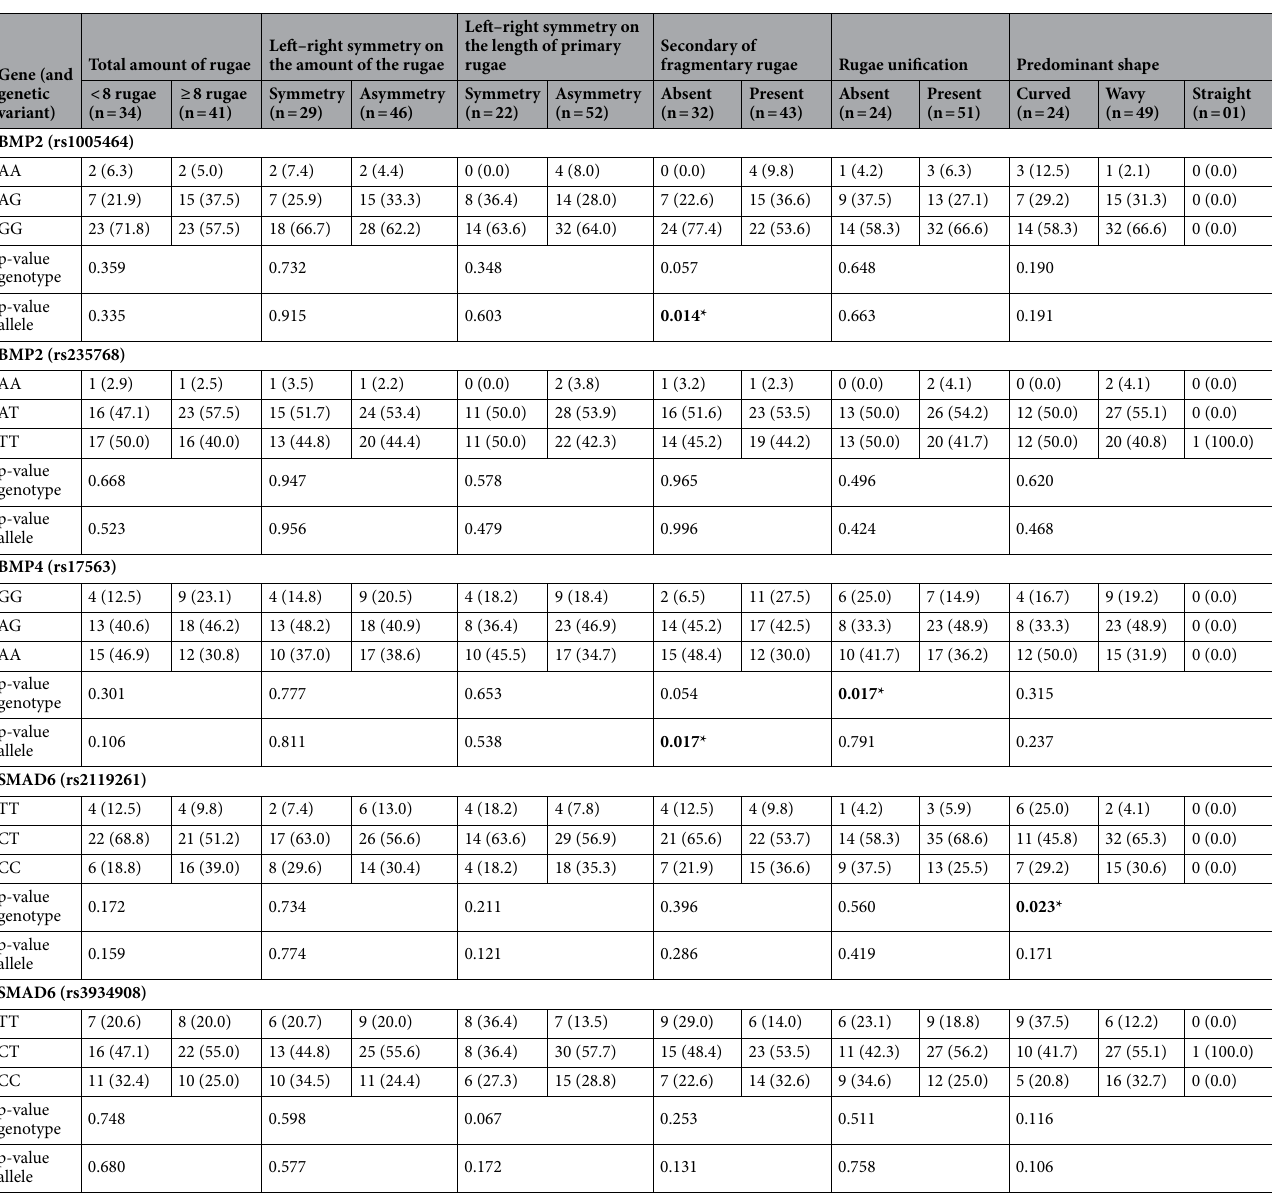
Table 2. Genotype and allele distributions for genetic variants in BMP2 (rs1005464 e rs235768), BMP4 (rs17563) and SMAD6 (rs2119261 e 3934908) according to palatal rugae patterns. * and bold indicate statistical significance difference (p <